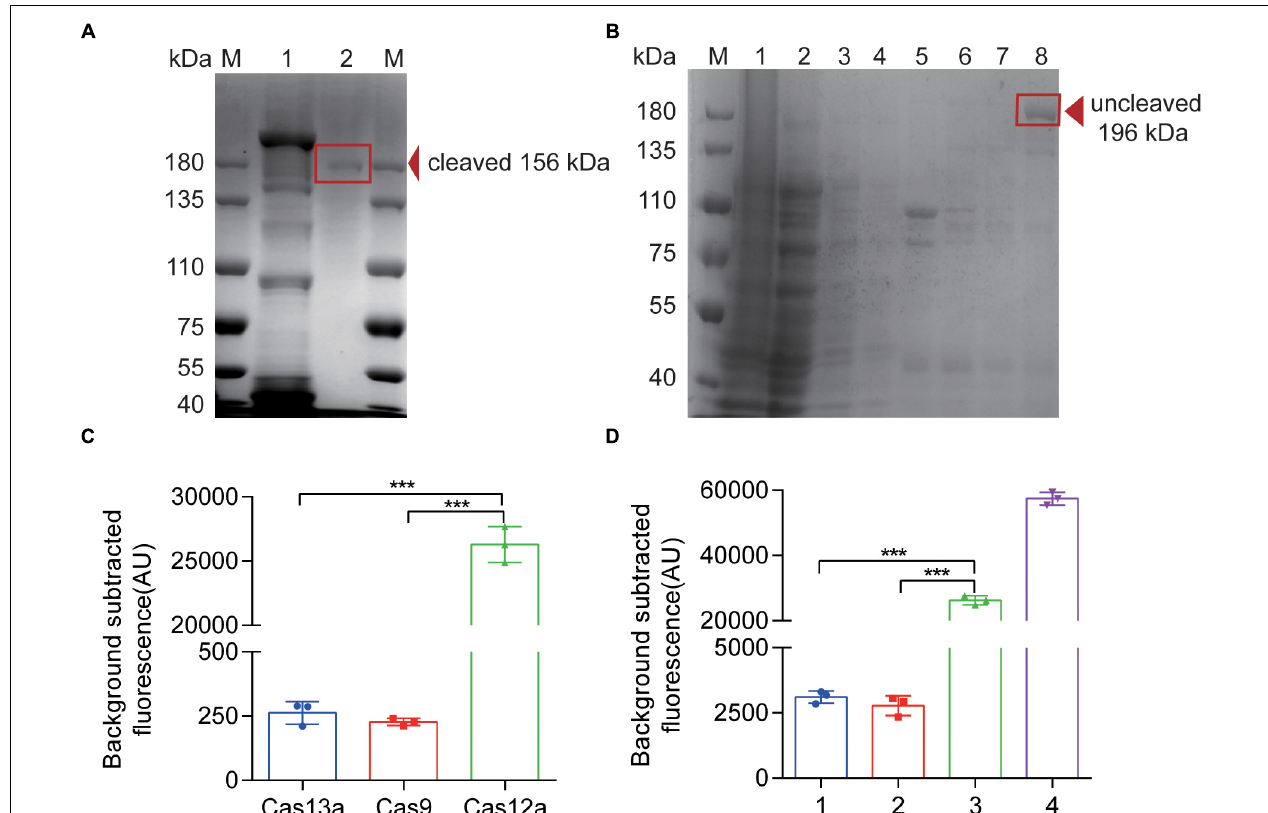
FIGURE 2 | Expression, purification, and verification of Cas12a protein. (A) SDS-PAGE of Cas12a protein. M, 180 kDa protein marker; 1, A band above 180 kDa eluted from the Ni-NTA column, consistent with the size of an MBP-AsCas12a fusion (196 kDa); 2, After digestion of the rTEV enzymes, a lower molecular weight band appeared, consistent with the size of 156 kDa, which was the pure AsCas12a. (B) SDS-PAGE of Cas12a protein. M, 180 kDa protein marker; 1, bacterial lysate pellet without IPTG induction; 2, bacterial lysis supernatant without IPTG induction; 3, bacterial lysis supernatant with IPTG induction; 4, flow through solution of purification; 5, 0.05 mol/L imidazole eluted proteins with UV value > 0.05; 6, 0.1 mol/L imidazole eluted proteins with UV value > 0.05; 7, 0.25 mol/L imidazole eluted proteins with UV value > 0.05; 8, 0.25 mol/L imidazole eluted proteins after concentration. (C) Fluorescence results of Cas12a activity verification compared with Cas13a and Cas9 proteins. (D) Fluorescence results of Cas12a activity verification. 1, false crRNA was added to the detection system instead of target crRNA; 2, inactive Cas12a (250 nM) is added to the detection system instead of Cas12a protein; 3, Complete detection system; 4, only DNase and the quenched fluorescent DNA probe reacted in RNase-free H 2 O. The data are presented as the mean ± SD from three independent experiments. *** p < 0.001. M,